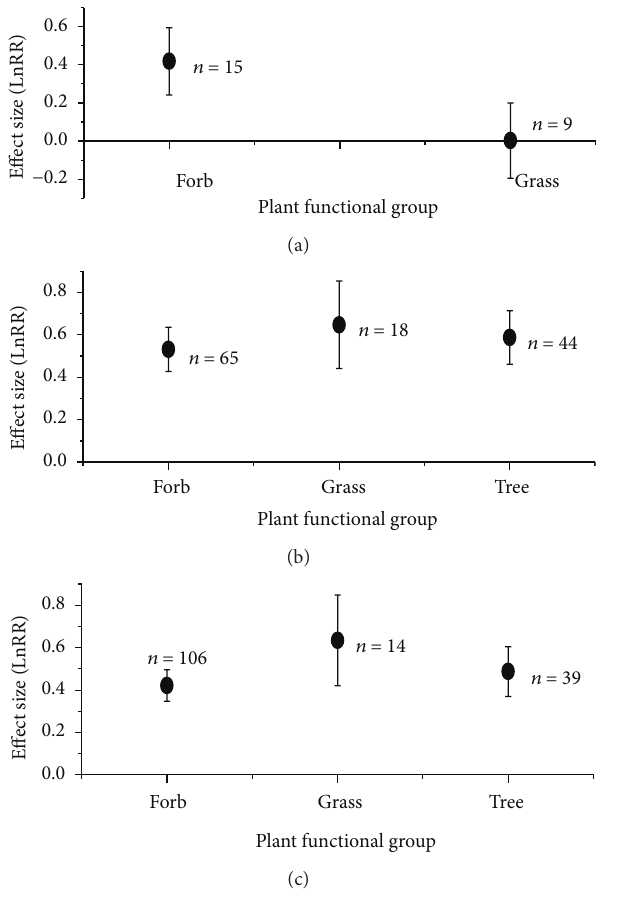
Figure 2: Effect size ( mean ± 95 % CI ) of plant functional groups to AMF under attacks of herbivores (a), nematodes (b), and fungal pathogens (c).